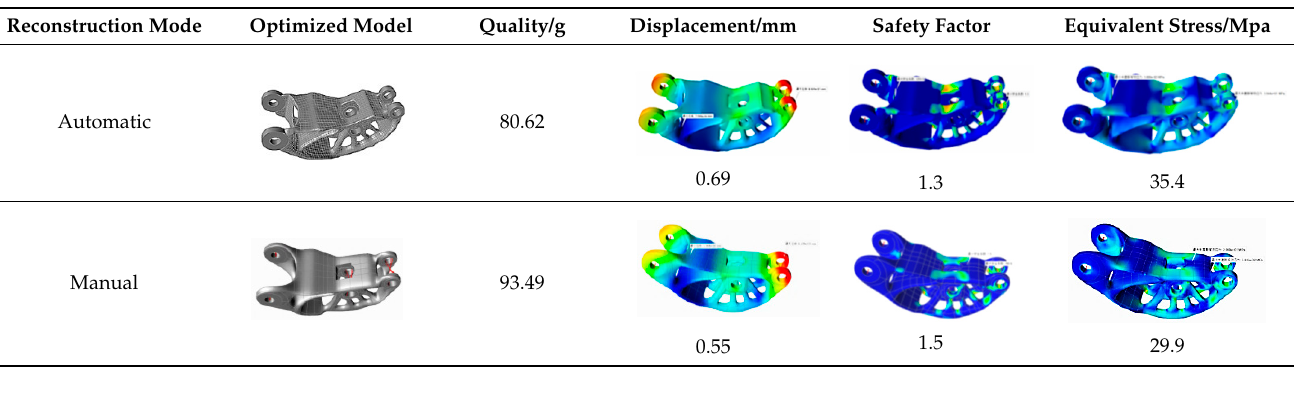
Table 2. Comparison of automatic and manual reconstruction optimization results.